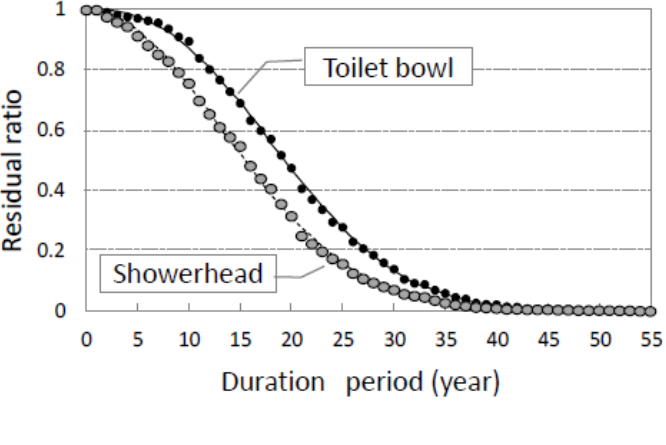
Figure 1. Duration distributions for household